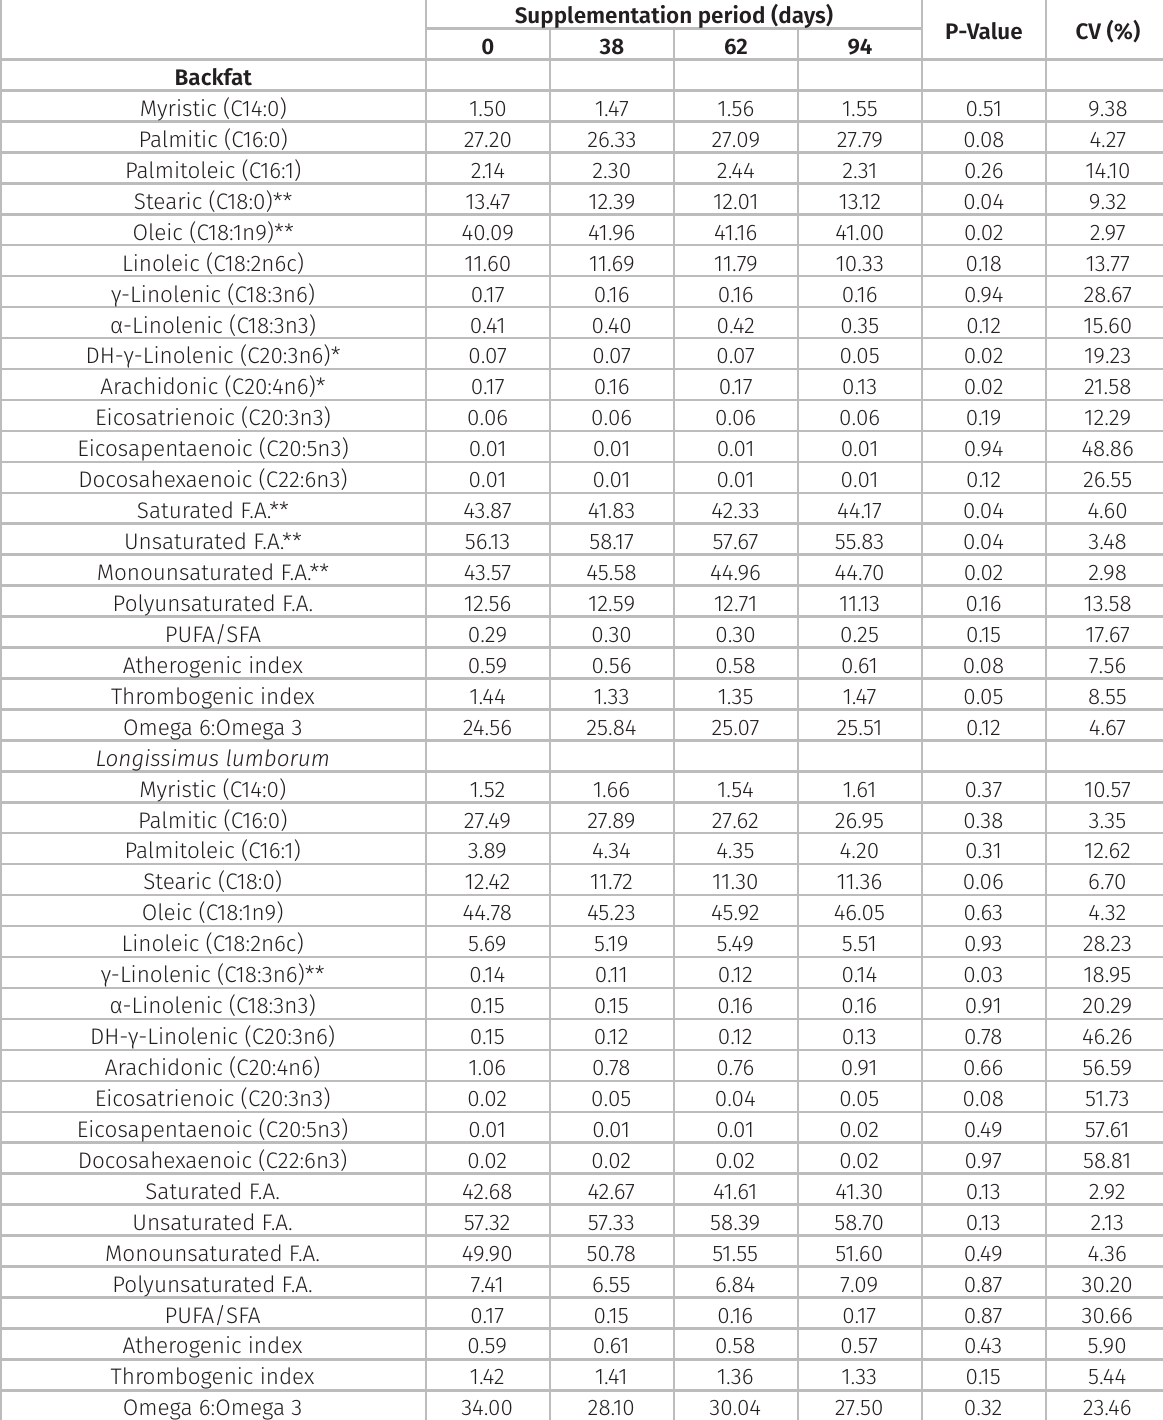
Table II. Fatty acid profile (% of total FA) of the backfat and Longissimus lumborum of barrows fed with chromium yeast for different periods before the